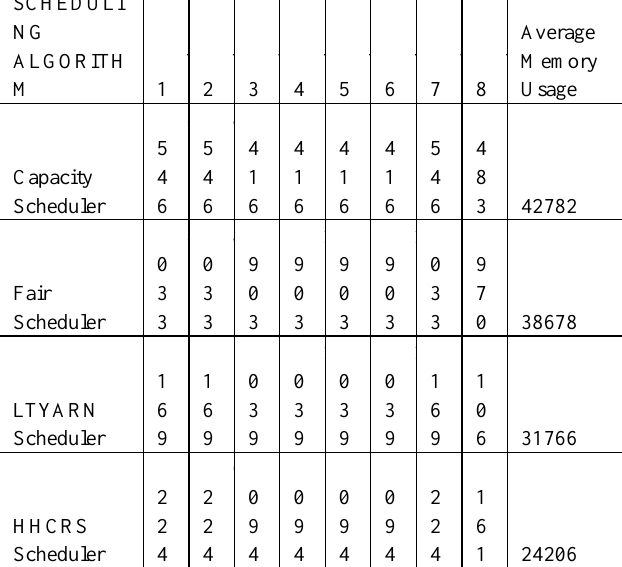
Table 6: Performance Measure - Memory Utilization